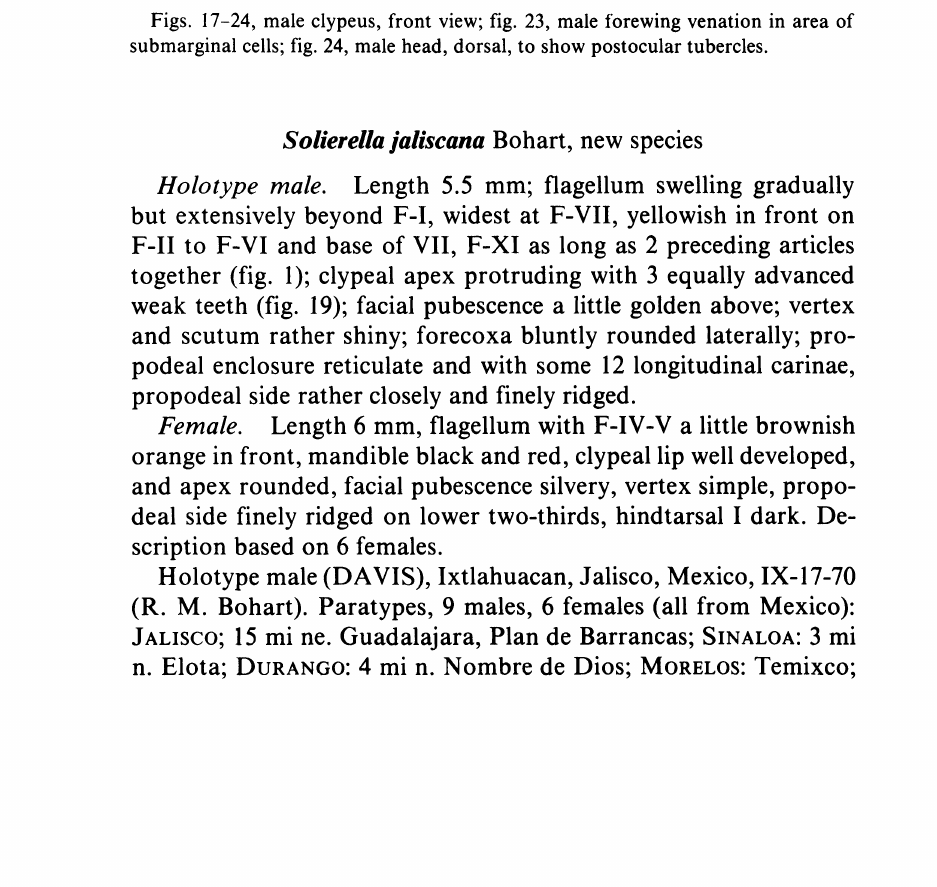
Figs. 17-24, male clypeus, front view; fig. 23, male forewing venation in area of submarginal cells; fig. 24, male head, dorsal, to show postocular